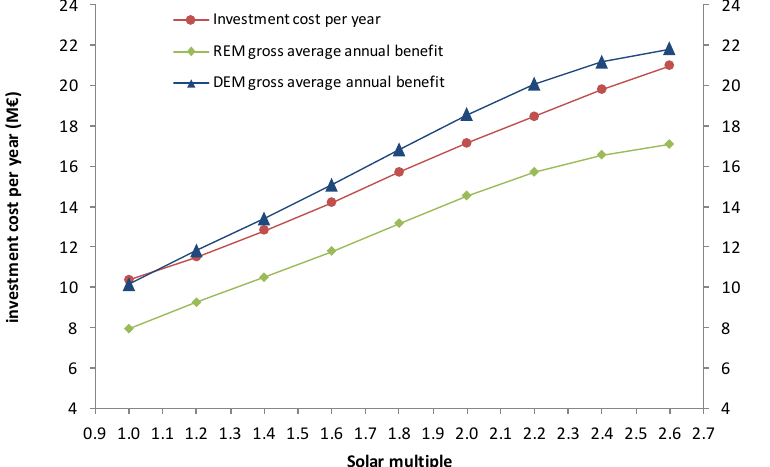
Figure 13. Investment cost per year and gross average annual benefit with SM for Area 2, Posadas.